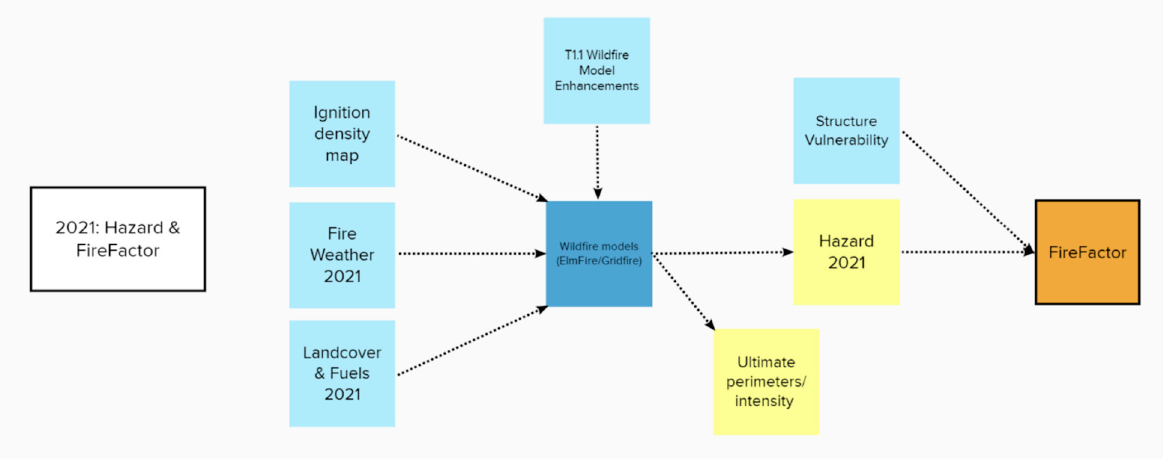
Figure 8. Wildfire behavior model, process diagram. The “fire factor” result on the right hand side is an expression of wildfire hazard as a function of burn probability, flame length, and ember presence and is available for viewing for every property in the U.S. at riskfactor.com (accessed on 8 August 2022).